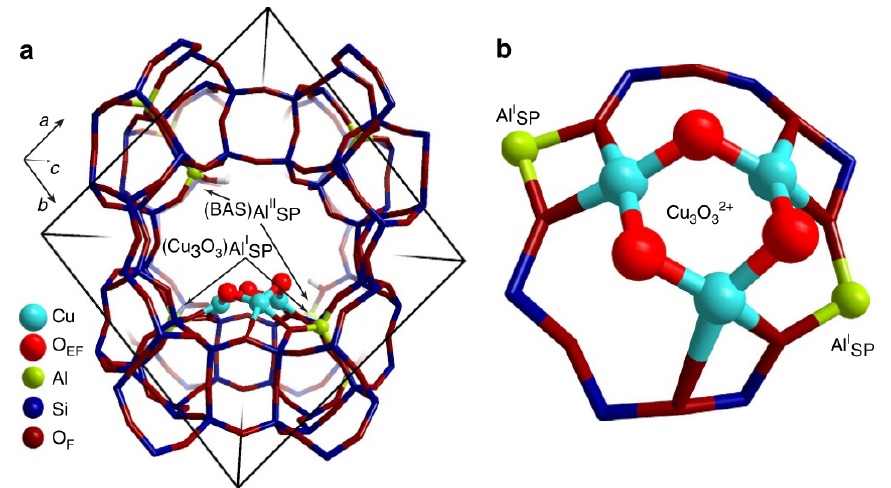
Figure 7. Structure of the trinuclear Cu-oxo cluster in MOR predicted by DFT calculation. In the figure, ( a ) is the main channel of MOR and ( b ) is the MOR side pocket. Reproduced with permission from ref [55]. Nature Publishing Group.